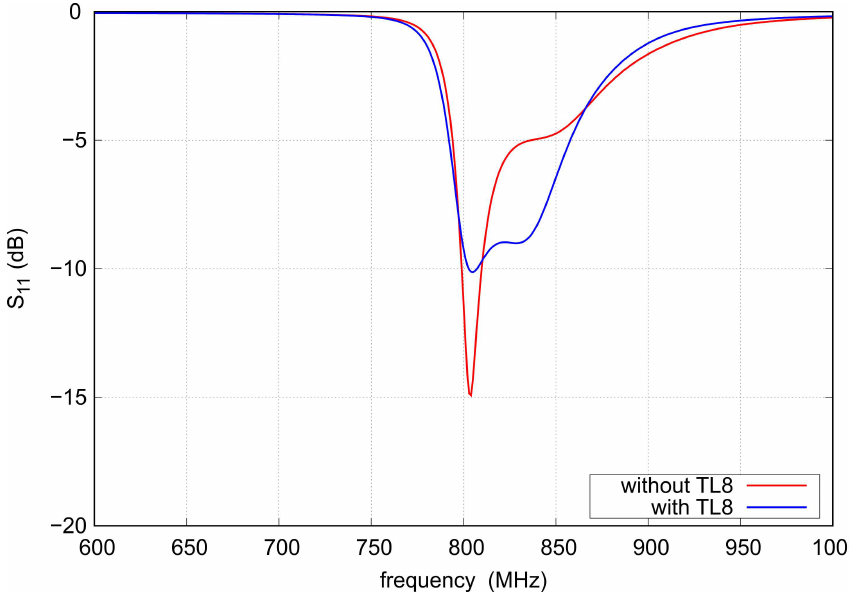
Figure 11. The S 11 calculated for circuit with and without